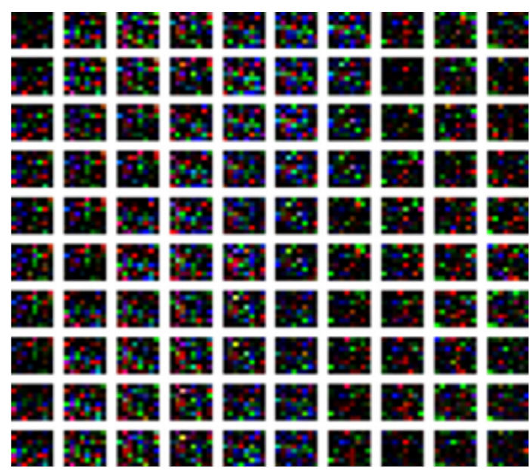
Figure 4. The learned dictionary.